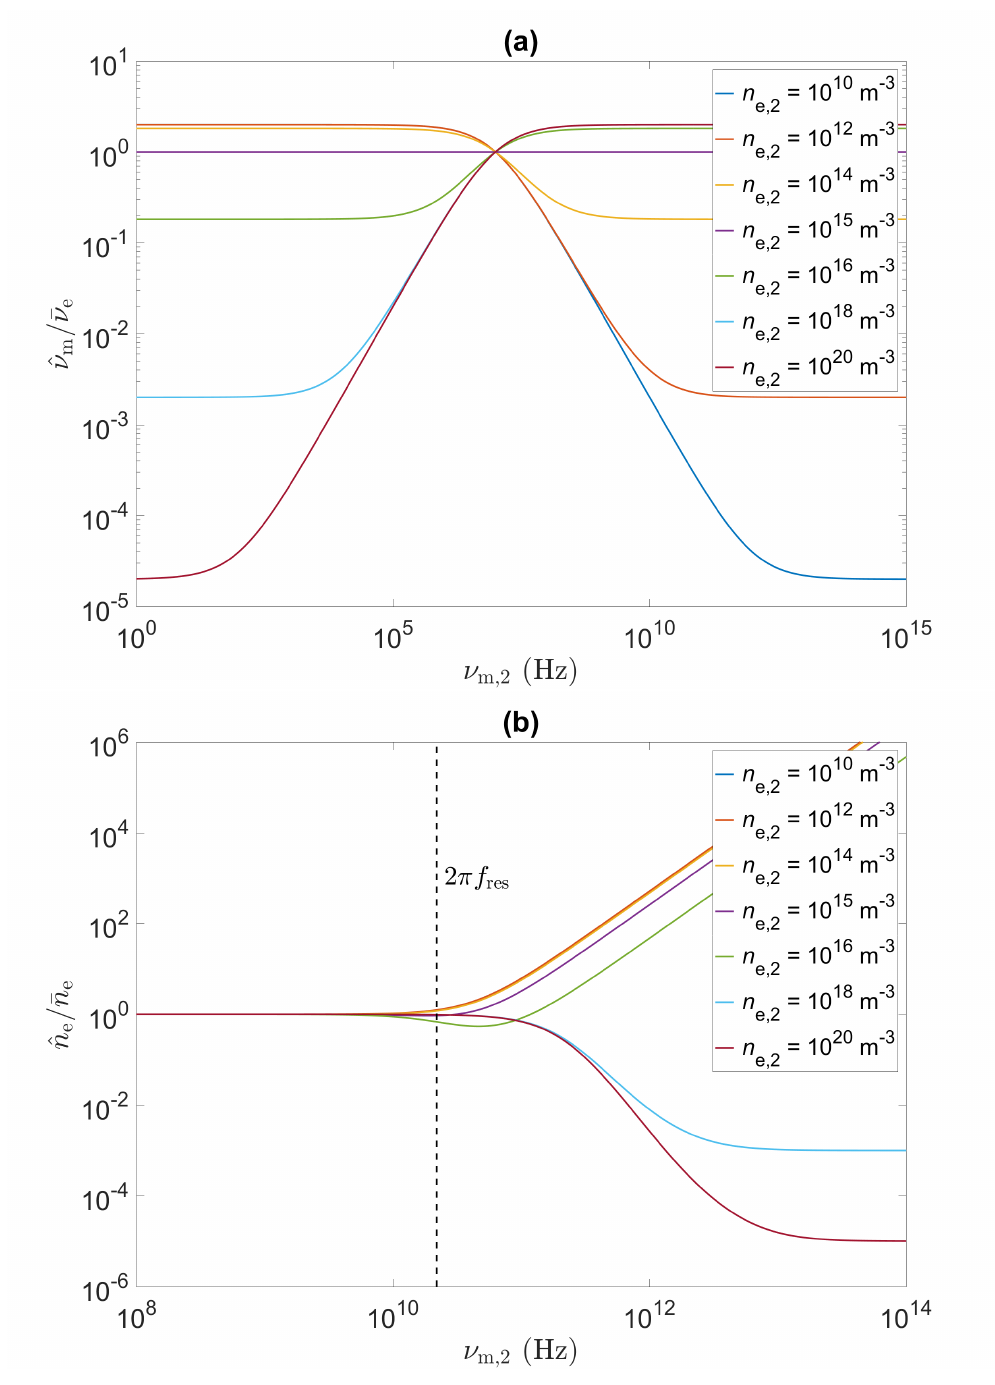
Figure 12. The ratio between the plasma parameters, i.e., ( a ) the collision frequency of the electrons and ( b ) the electron density, obtained by the measurement approach used for collisional plasmas and the electric-field-squared-weighted averaged values as a function of the collision frequency in region 2 ν m,2 for several n e,2